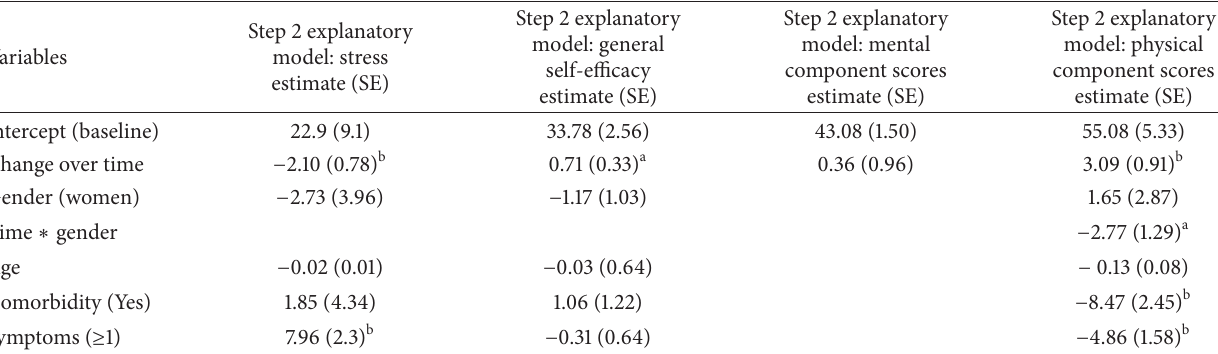
Table 4: Adjusted mixed-effect models for longitudinal mean changes in stress, general self-efficacy, and mental and physical component scores ( 𝑛 = 37